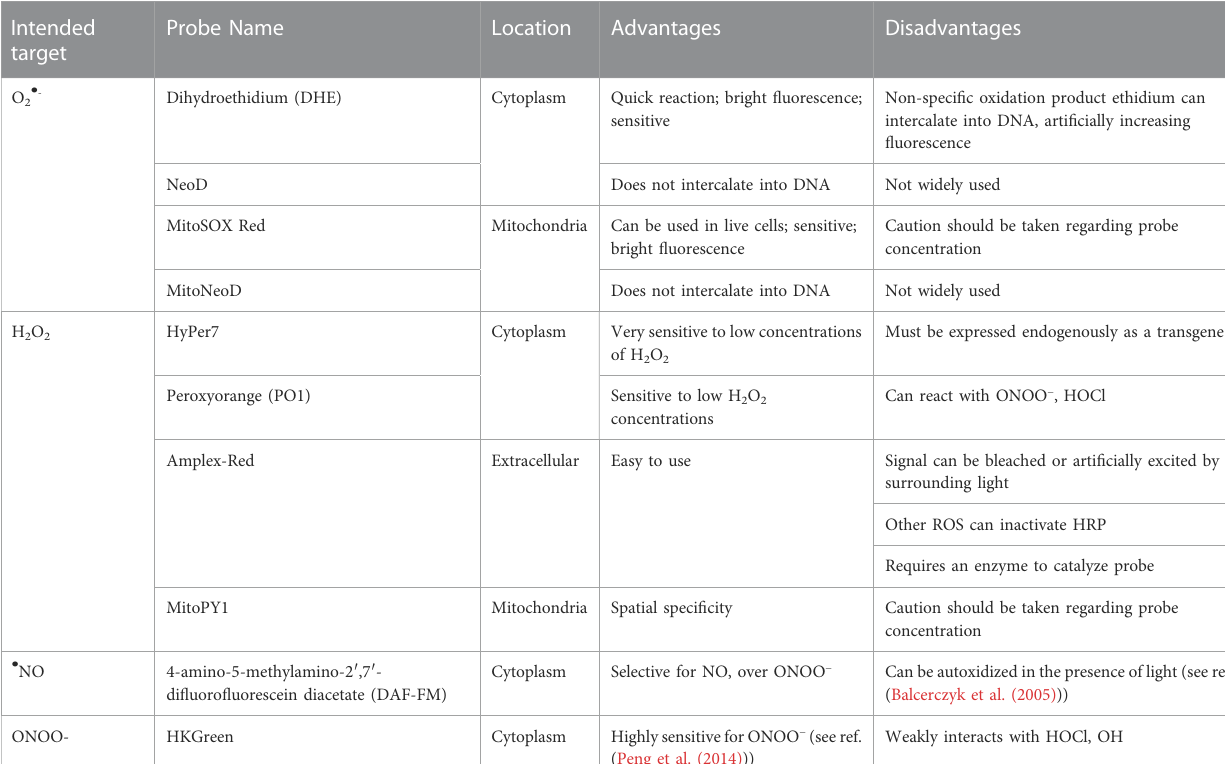
TABLE 2 Recommended fl uorescent probes for assessing redox